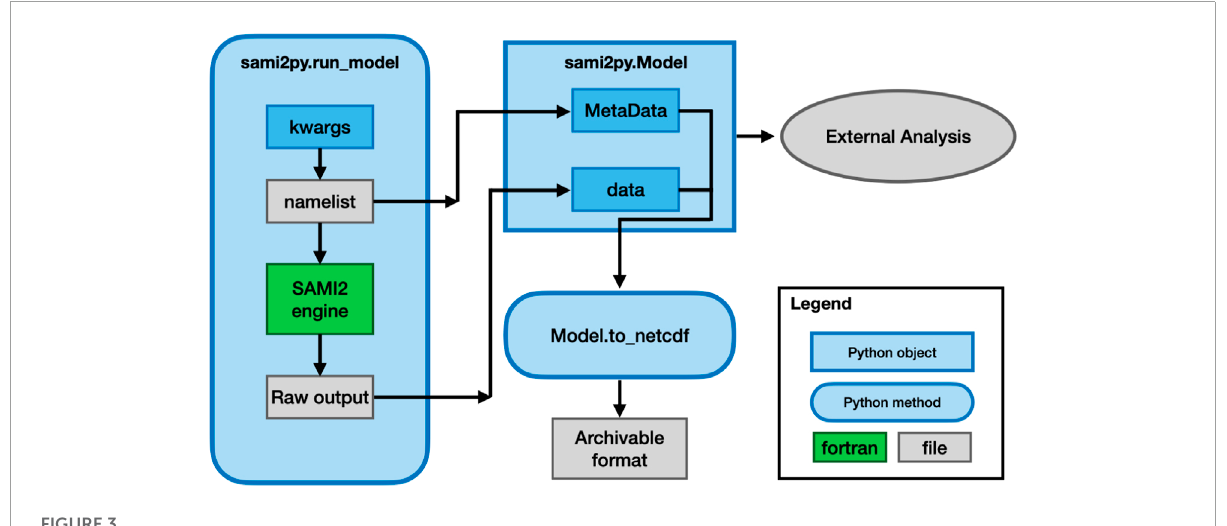
FIGURE 3 Block diagram of the sami2py workflow.